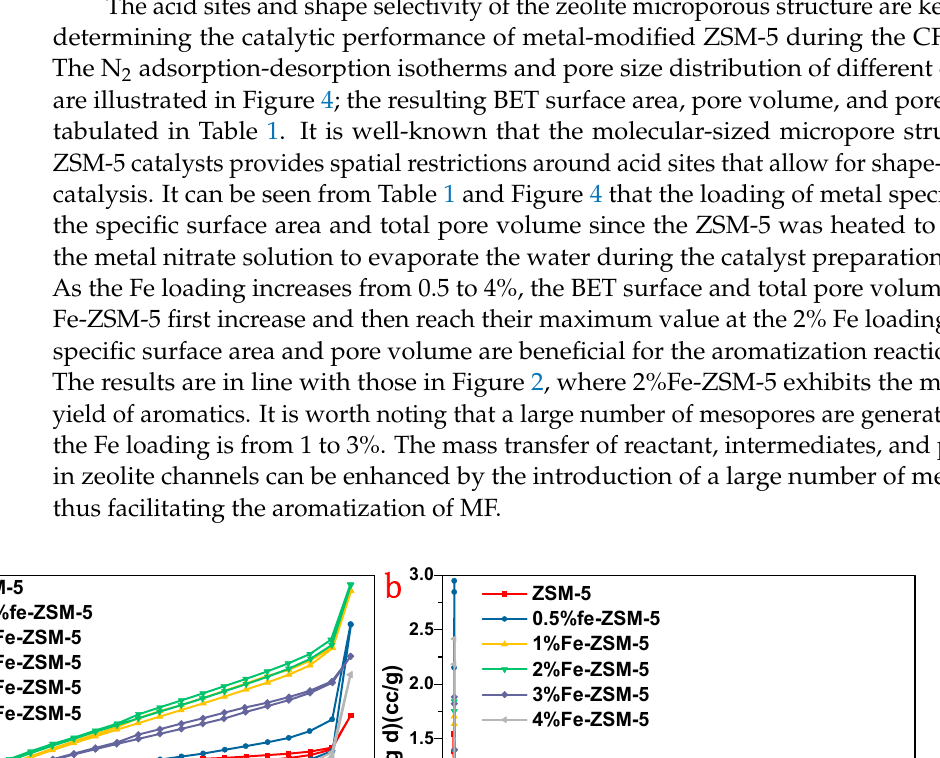
Table 1. The BET surface area, pore volume, and pore size of different catalysts.